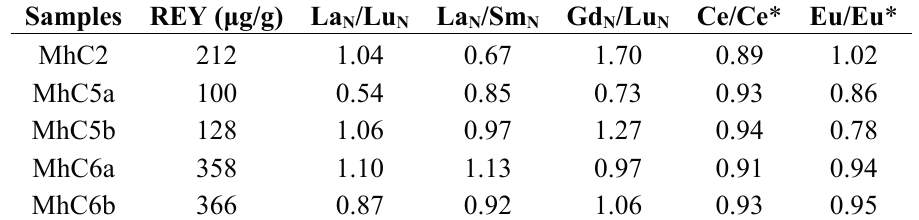
Table 4. Rare earth elements and yttrium (REY) concentrations and parameters in the Mahe coals, normalized to Upper Continental Crust